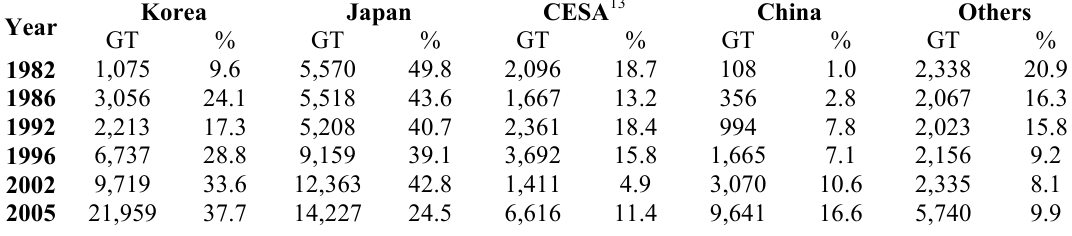
Table 2: Shipbuilding (Completion) Statistics by Year, Measured in Million Gross Tons Korea Japan CESA 13